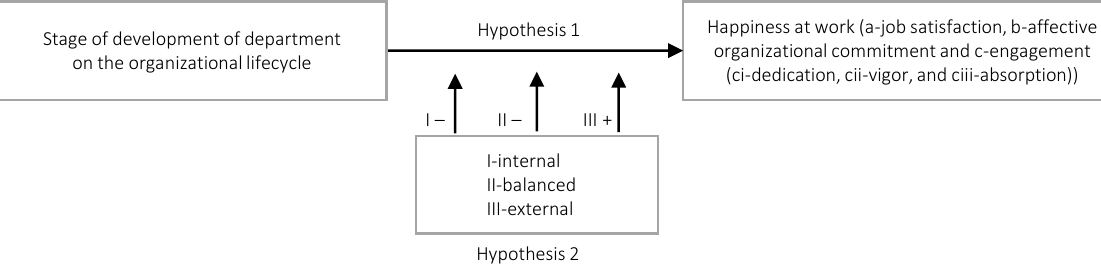
Figure 1. Conceptual